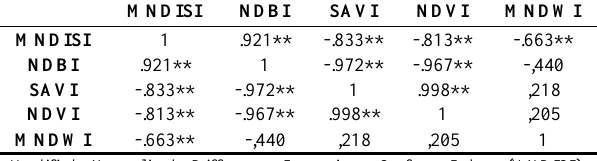
Table 2. The Pearson correlation matrix.